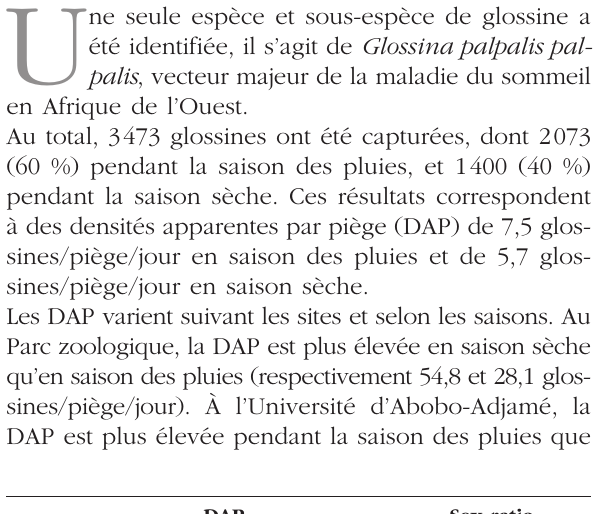
Fig. 2. - Représentation de la distribution des glossines par l’ana- lyse factorielle des